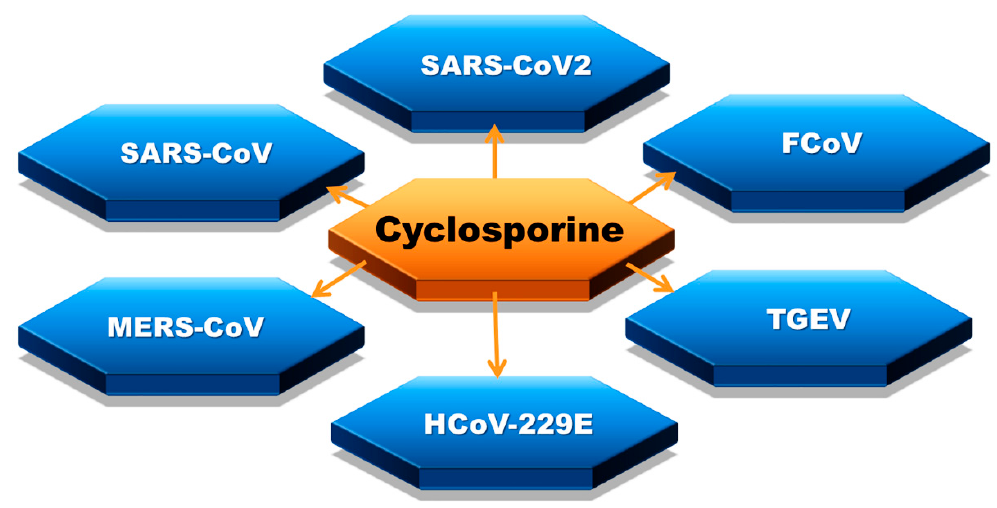
Figure 2. Coronaviruses affected by cyclosporine: severe acute respiratory syndrome coronavirus 2 (SARS-CoV2), severe acute respiratory syndrome coronavirus (SARS-CoV or SARS-CoV1), feline coronavirus (FCoV), Middle East respiratory syndrome coronavirus (MERS-CoV), transmissible gastroenteritis virus (TGEV), human coronavirus 229E (HCoV-229E).